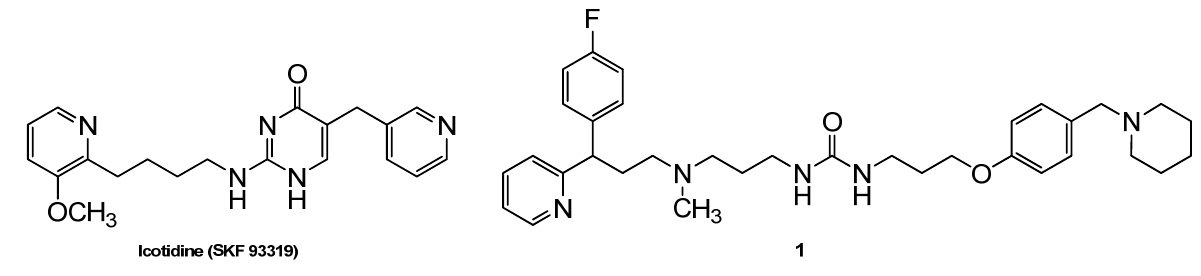
Figure 1. Icotidine (SK&F 93319) and lead compound 1 .